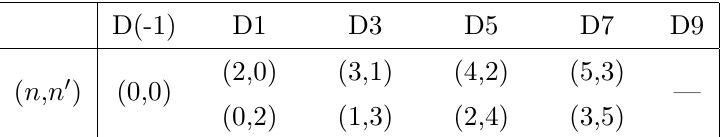
Table 1 . 1/2-BPS D-branes in the AdS 5 (cid:2) S 5 background. n ( n 0 ) represents the number of Neumann directions in AdS 5 (S 5